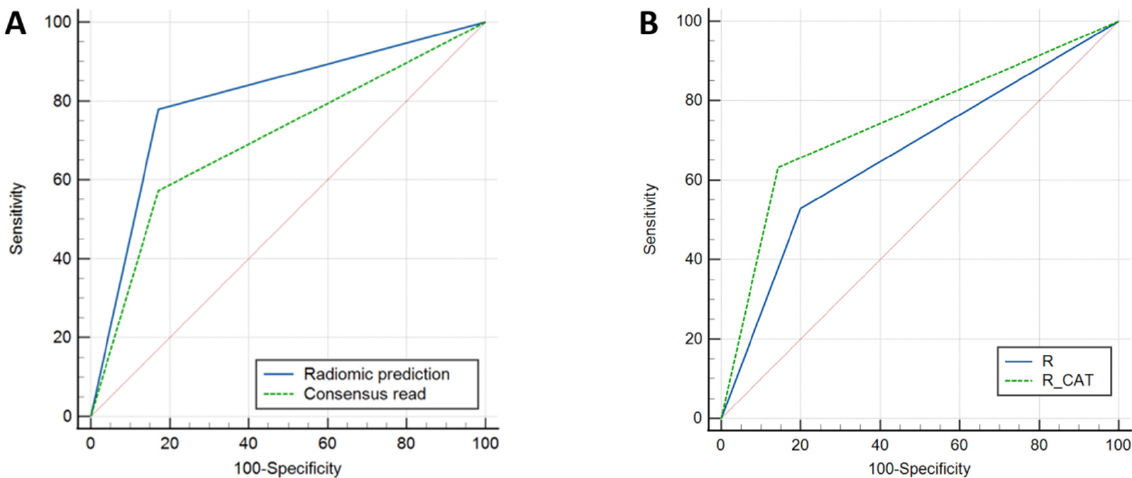
Figure 3. Receiver ‐ operating characteristic (ROC) curves for prediction of 1p/19q co ‐ deletion status. Figure 3. Receiver-operating characteristic (ROC) curves for prediction of 1p/19q co-deletion status. ( A ) Comparison of radiomics model to consensus T2 ‐ FLAIR mismatch with AUCs of 0.80 and 0.70, ( A ) Comparison of radiomics model to consensus T2-FLAIR mismatch with AUCs of 0.80 and 0.70, respectively ( p = 0.044). ( B ) Comparison of radiologist T2 ‐ FLAIR mismatch alone to combined ra ‐ respectively ( p = 0.044). ( B ) Comparison of radiologist T2-FLAIR mismatch alone to combined diologist + radiomic (computer ‐ assisted tool) with AUCs of 0.66 and 0.74, respectively ( p = 0.019). radiologist + radiomic (computer-assisted tool) with AUCs of 0.66 and 0.74, respectively ( p = 0.019).